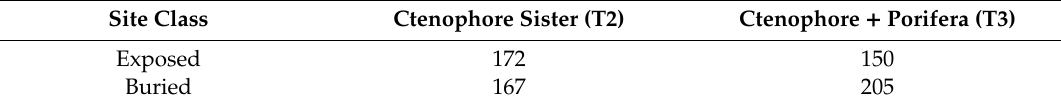
Table 2. Decisive sites favoring topology T2 vs. T3 in the exposed and buried residues a